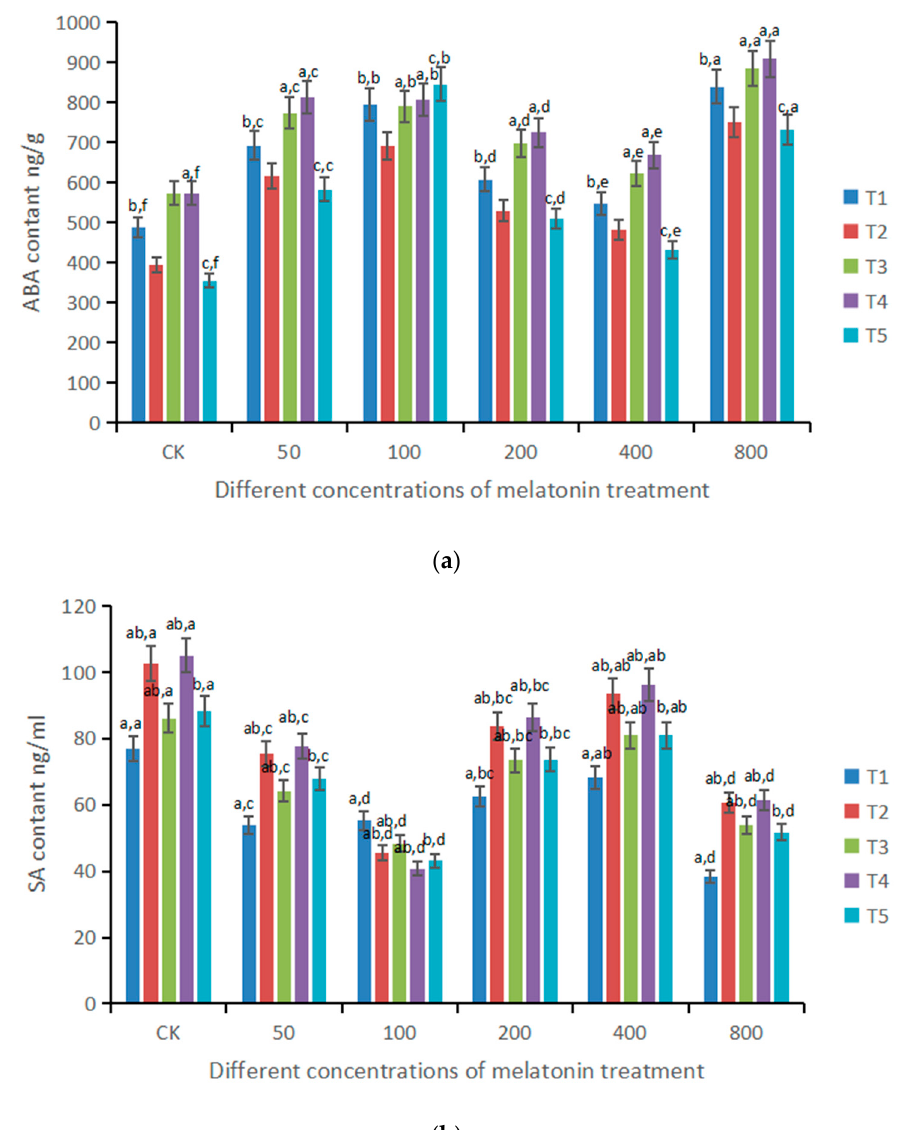
Figure 6. Relative ABA and SA content of Populus cathayana × canadansis ‘Xin lin 1’ leaves under control and different MT treatments based on salt and alkaline stress in different time periods of the experiment. T1 means 10 days, T2 means 14 days, T3 means 18 days, T4 means 22 days, T5 means 26 days. Each value is the average ± standard error ( ± SE). For two-way ANOVA, the letters on the left represent the detection phase ( p < 0.05) and the letters on the right represent the experimental concentrations ( p < 0.05). Letters such as a-f are used in this figure to indicate the degree of difference between groups ( a ) Changes of ABA content, ( b ) changes of SA content.